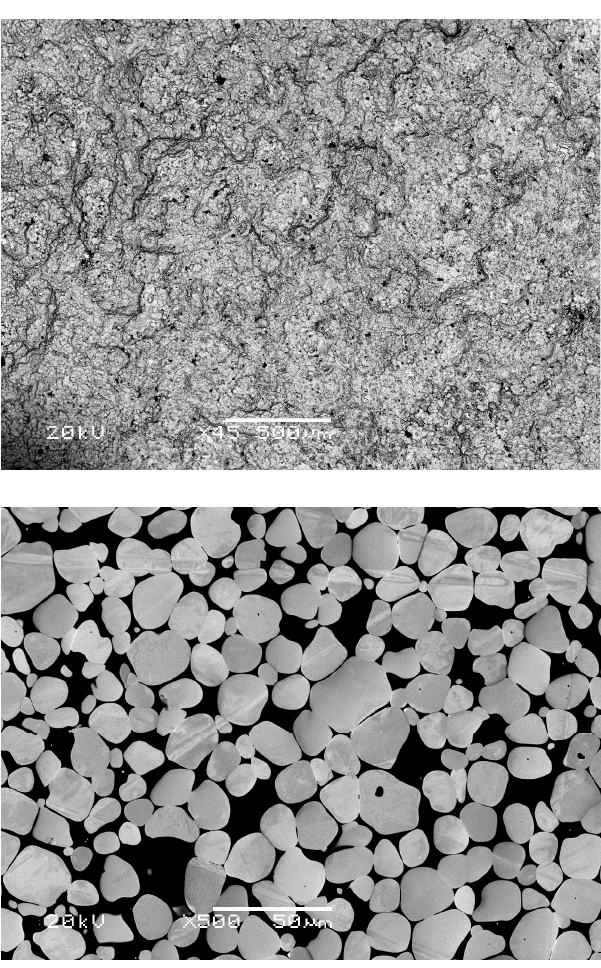
FIG. 8. (Color) Scanning electron microscope comparisons of stainless steel alloy 410 (top) and 304L (bottom). Pictures are cross sections through arc-damage locations. Several images were taken and these are representative of those images.